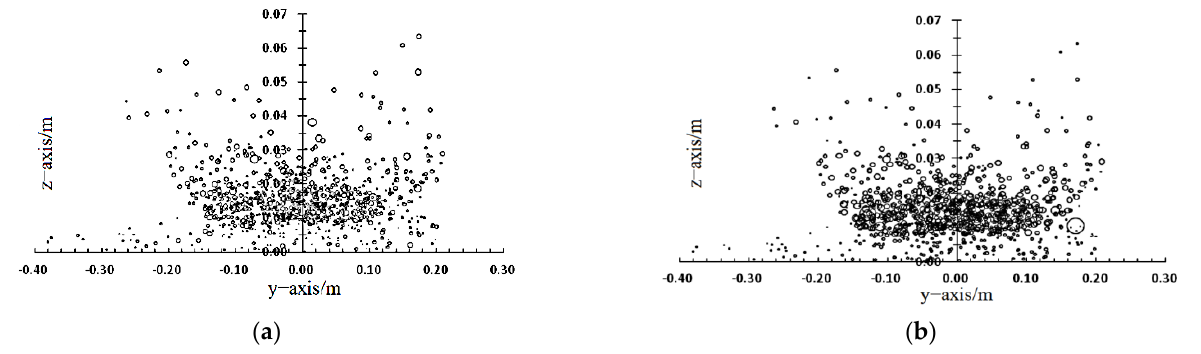
Figure 19. Distribution characteristic of the paint mist: ( a ) paint mist diameter distribution; ( b ) paint mist velocity distribution.